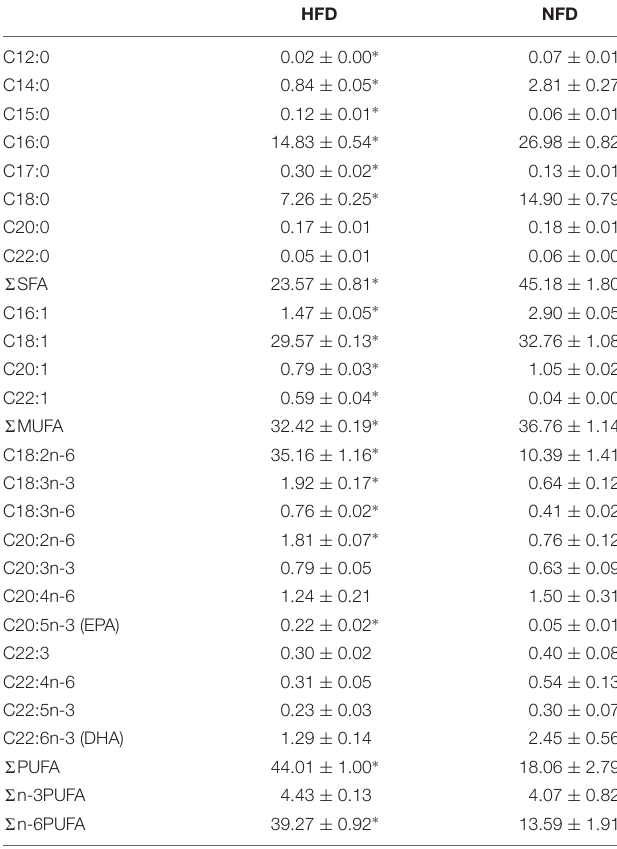
TABLE 4 | Fatty acid composition in liver in GIFT fed a HFD or NFD for 60 days (% of total